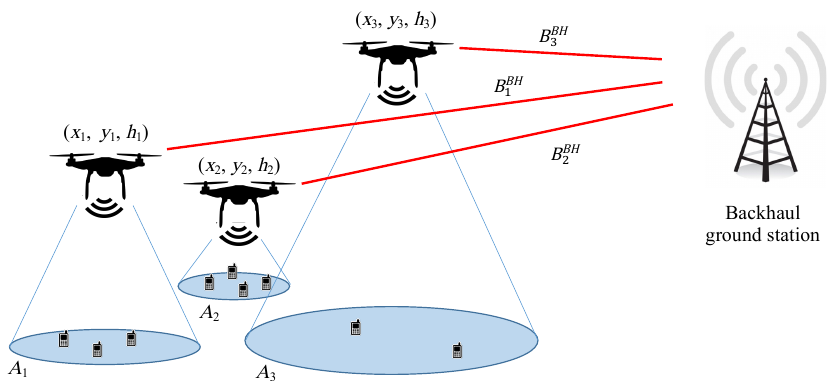
Figure 1. Example of a complete scenario: three ABBSs linked through a wireless connection to a backhaul ground